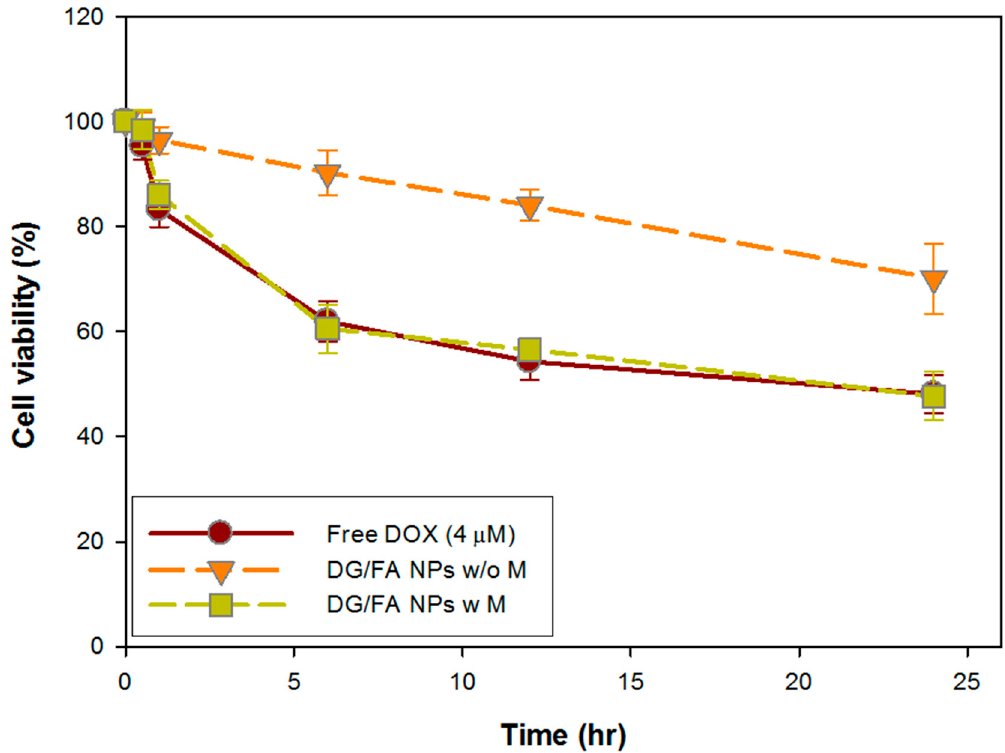
Figure 7. Cytotoxicity assay of free DOX and DG / FA NPs with or without external magnetic field.